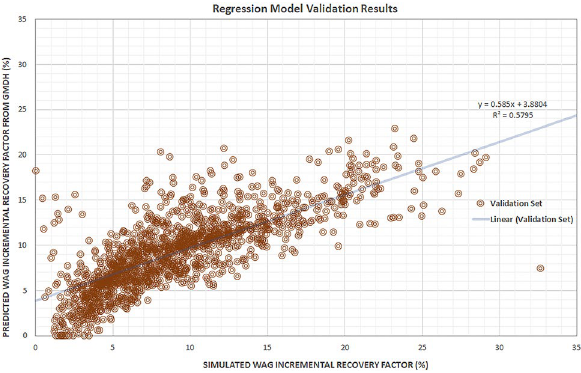
Fig. 13 Regression WAG incremental recovery factor prediction model training results